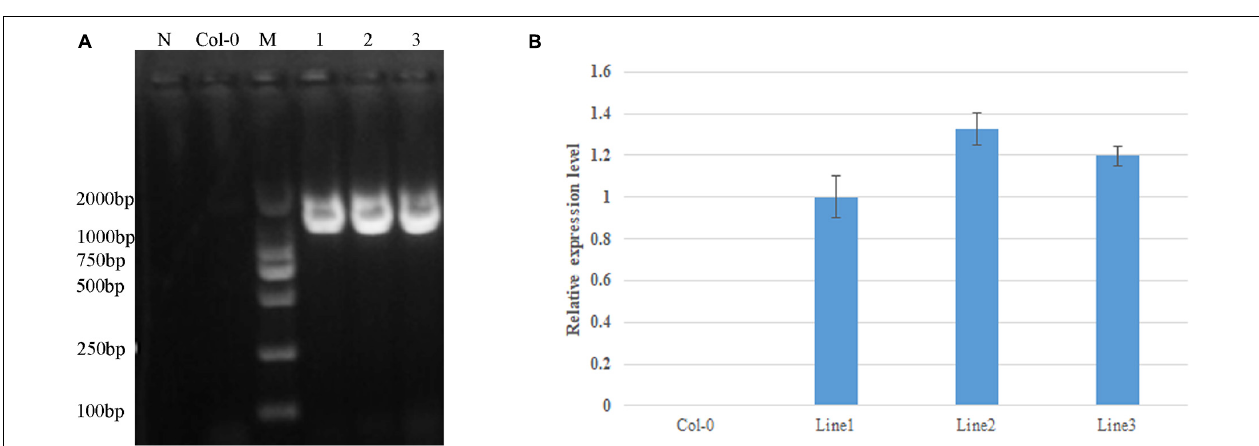
FIGURE 5 | Identification of GhDA1-1A R 301 K transgenic plants by PCR. (A) The primers used were 35S-F in the 35S promotor and GhDA1-1A-R in the GhDA1-1A gene ( Supplementary Table 1 ). The “N” is the negative control without any DNA. (B) Relative expression level of GhDA1-1A in three transgenic Arabidopsis lines. The (cid:49) Ct value of GhDA1-1A in transgenic line 1 was set as the control. The data presented are the means ± SD of three biological replicates.